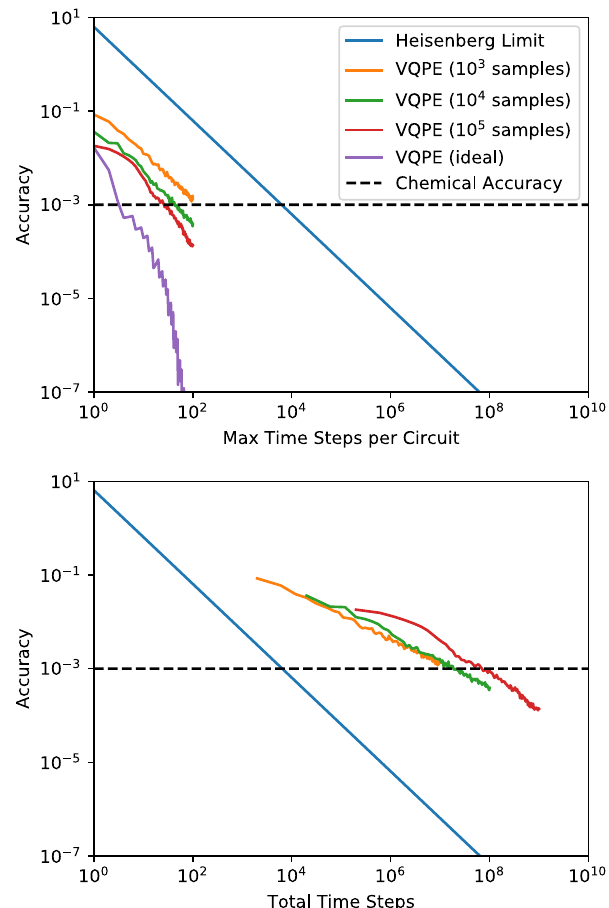
FIG. 5. Accuracy comparison between VQPE and the Heisen- berg limit for the ground-state energy of LiH. Varying numbers of samples per expectation value are shown for VQPE alongside the idealization of VQPE without finite-sampling errors. We use SVD cutoffs of 2, 0.9, and 0.3 respectively corresponding to 10 3 , 10 4 , and 10 5 samples and 10 − 6 for the ideal case. All methods use (cid:10) t = 0.5. The top and bottom plots show the maximal evolution time (i.e., how many time steps need to be included for energy convergence), related to the circuit depth, and the total evolution time, i.e., the sum of all time segments